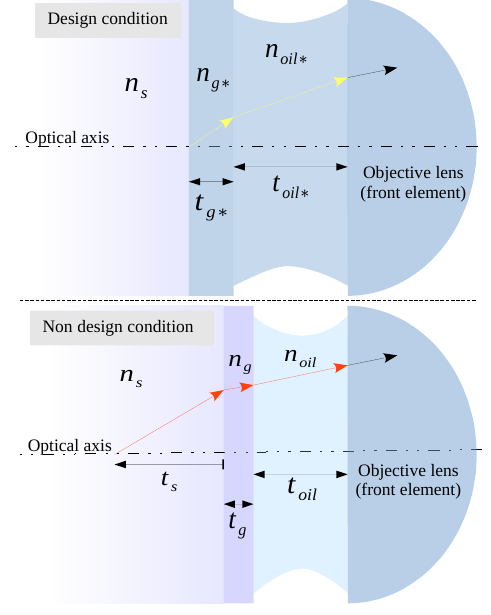
Figure 1. Path ray scheme for design and non-design